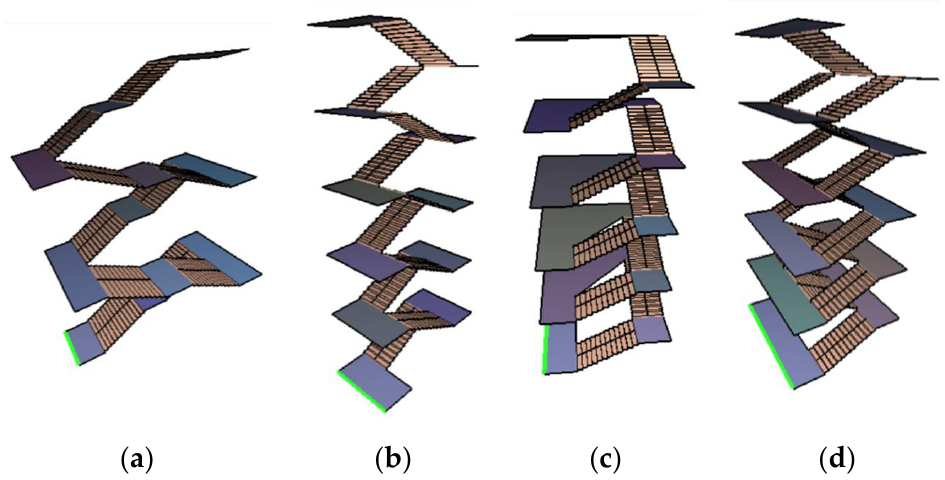
Figure 6. Simulation model of four staircases. ( a ) Straight running stairs with platform (SSP); ( b ) double running parallel stairs (DPS); ( c ) corner stairs (CS); ( d ) double split parallel stairs (DSS).